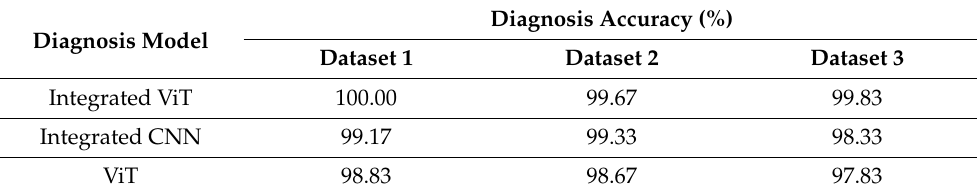
Table 4. Diagnosis results of three diagnosis models on three